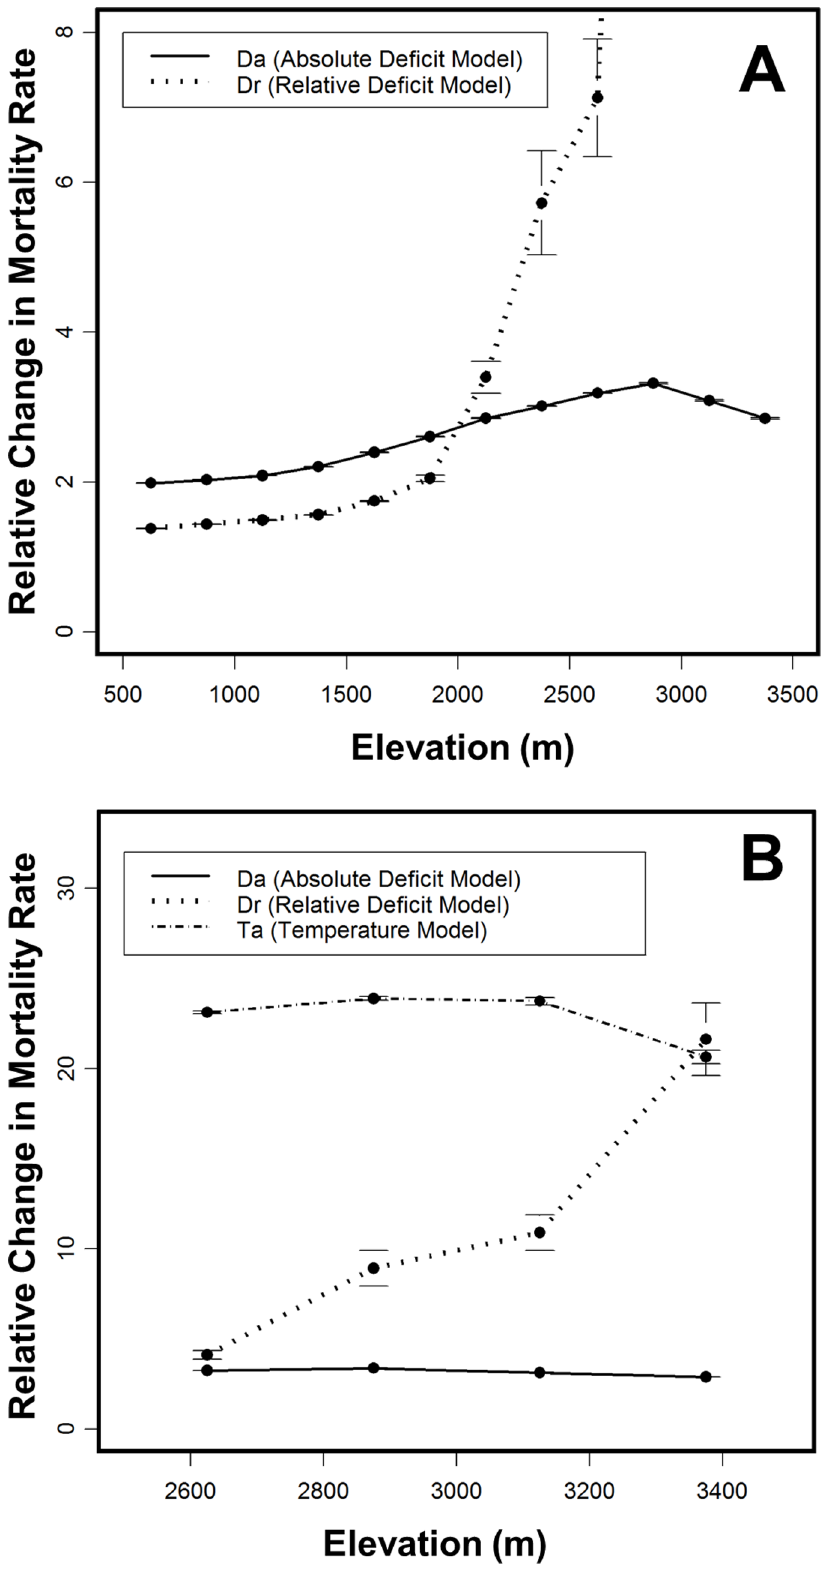
Figure 3. Projected Changes in Mortality Rate by Elevation (Hypothetical). Projected relative changes in tree mortality rate by elevation in the 2090s for the GFDL A2 climatic scenario using (A) D a and D r exponential models for all forests and (B) the D a , D r , and T a exponential model for energy-limited forests. Rates are averaged in 250 m classes using the 33,594 Sierra Nevada coniferous forest grid points. Error bars show standard